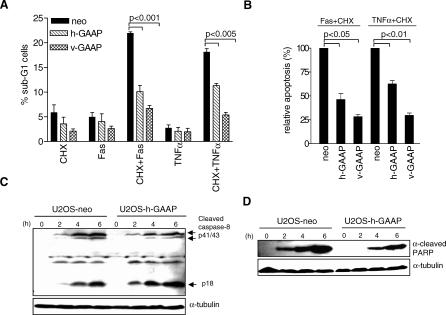
h-GAAP Decreases Cell Susceptibility to Extrinsic Apoptosis Pathways(A) U2OS-neo, U2OS-v-GAAP, or U2OS-h-GAAP cells were treated with 10 μg/ml of CHX alone or together with 500 ng/ml of anti-Fas Ab or 10 ng/ml of TNF-α. The bar graph represents the percentage of apoptotic cells (± 1 SD) after 24 h.(B) Relative inhibition of Fas and TNF-α–induced apoptosis in U2OS-neo (designated as 100%), U2OS-v-GAAP, and U2OS-h-GAAP cells. Data are mean percentages (± 1 SD) from at least three independent experiments. Statistically significant differences are shown.(C and D) After 2, 4, or 6 h incubation with TNF-α and cycloheximide, proteolytic cleavage of caspase-8 into p43/p41 and p18 fragments (C) and PARP (D) were assessed by immunoblotting.